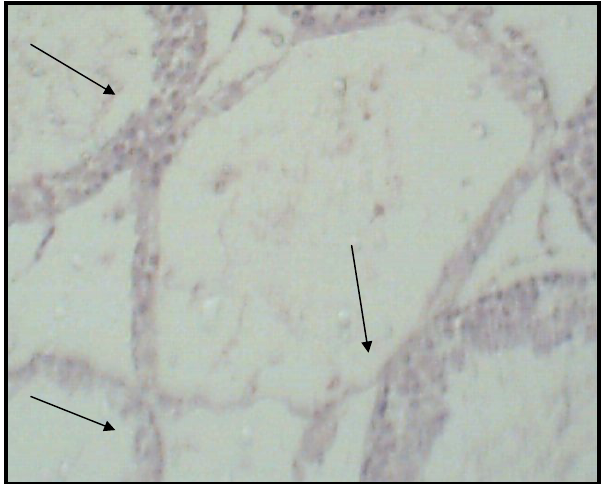
FIGURE 5 - Photomicrography of a seminiferous tubule of an adult hamster of the control group showing all the stages of the spermatogen- esis and the plenty of spermatozoids inside the lumen (arrow) (HE 40x).